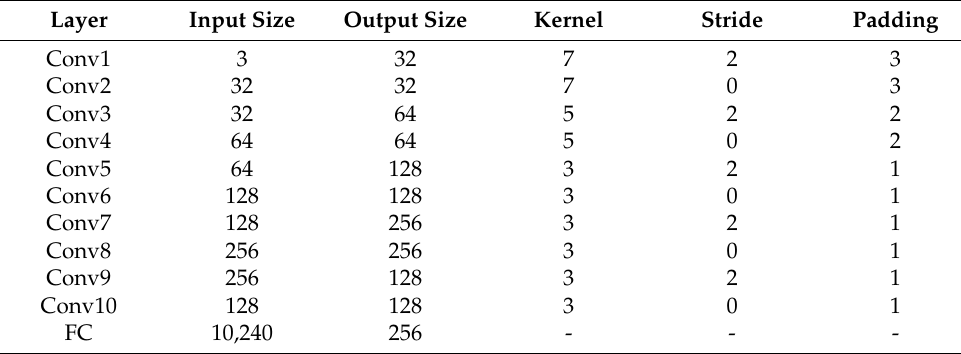
Table 2. Parameter Setting for the Encoder.